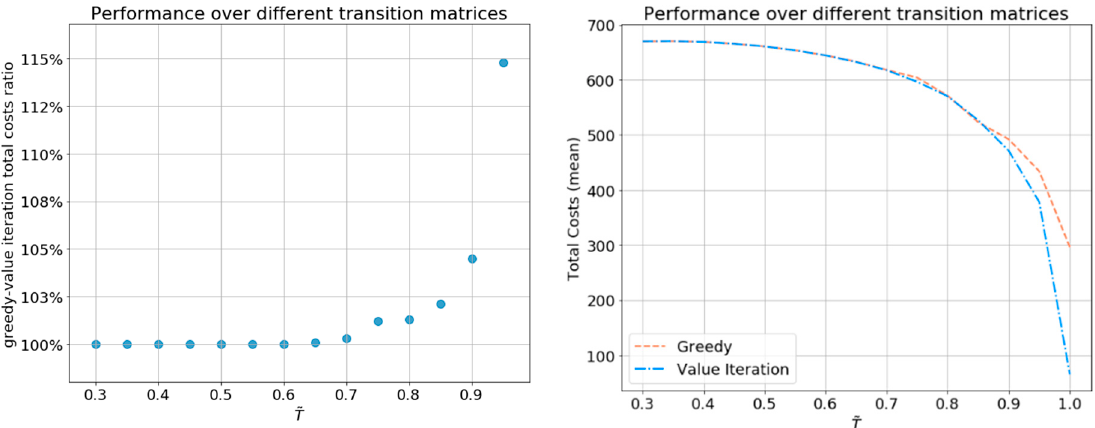
Figure 13. Total costs of the greedy policy and the value iteration policy over different transition matrices T , defined by 0.3 ≤ (cid:101) T ≤ 1 (step size 0.05), averaged over 100 i.i.d. Monte Carlo